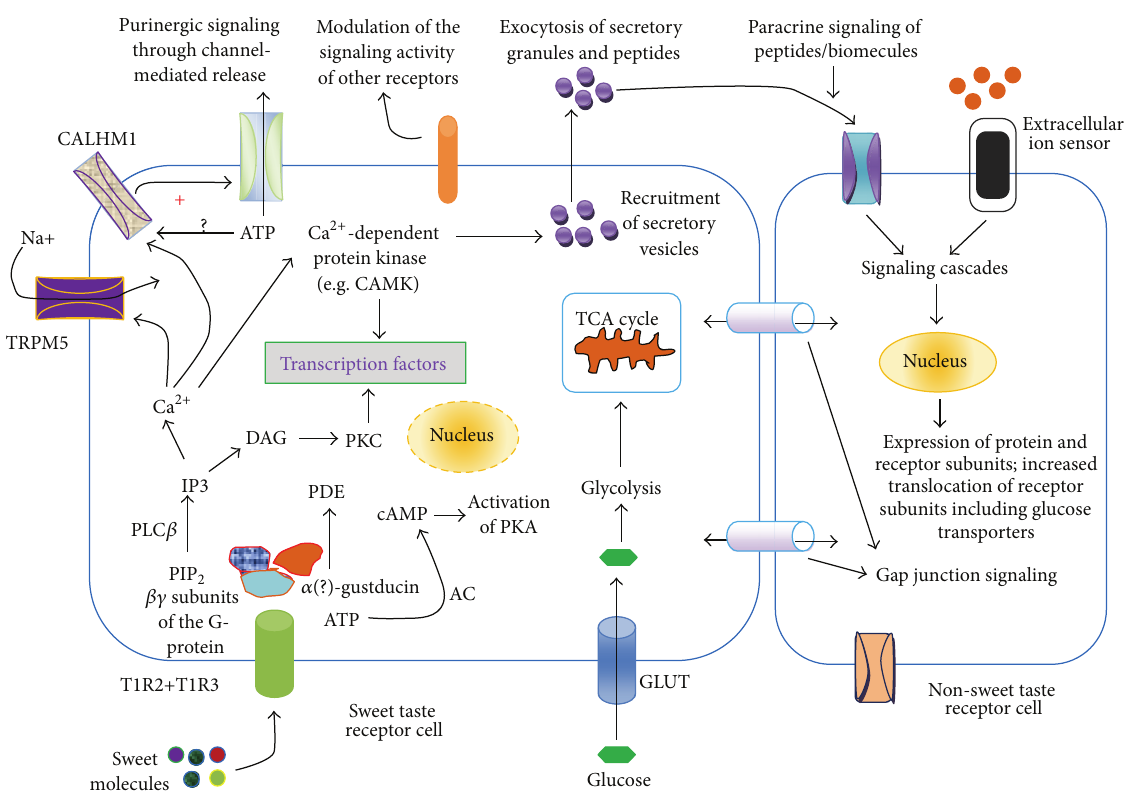
Figure 1: A general model of sweet taste signaling network. Sweet taste receptors possess multiple binding sites and mode of interaction for sweet molecules and they belong to class C of heterotrimeric guanine nucleotide-binding protein, G-protein [143–145]. Sweet molecules activate the G-protein by downstream signaling leading to the dissociation of the 𝛼 -subunit gustducin from the 𝛽𝛾 subunits [146, 147]. Dissociated 𝛽𝛾 subunits of the G-protein activate phospholipase C 𝛽 (PLC 𝛽 ), leading to the formation of 1,4,5-inositol trisphosphate (IP3). IP3 is responsible for the release of Ca 2+ from intracellular stores through its binding to IP3-receptor in these stores. Increase in intracellular Ca 2+ activates calcium dependent kinase, monovalent selective cation channel, TRPM5 (transient receptor potential cation channel, subfamily M, member 5) [15, 44, 146], and other receptors [44, 148]. To establish the role of TRPM5 or PLC 𝛽 (type 2), Zhang et al. [4] showed that knockout of the receptor or the enzyme abolishes the sensation of taste in cells. TRPM5 may also play a role in capacitance mediated calcium entry into taste cells [147]. Modulation of purinergic signaling by taste receptor also plays useful role in taste sensation. For the initiation of purinergic release, it was recently demonstrated by Taruno et al. [148] that the voltage-gated ion channel, calcium homeostasis modulator 1 (CALHM1),isindispensablefortaste-stimuli-evokedATPreleasefromsweet,bitter,andumamitastecells.Importantly,CALHM1isexpressed not only in sweet but also in bitter and umami taste sensing type2 cells. Taruno et al. [148] proposed that CALHM1 is a voltage-gated ATP- release channel. Dissociated 𝛼 subunit referred to as G 𝛼 -gustducin activates a phosphodiesterase (PDE) thereby decreasing intracellular cAMP levels [146, 149]. G 𝛼 -gustducin is also reported to activate adenylate cyclase (AC) to increase cAMP level [150]. According to earlier report, Clapp et al. [151] demonstrated that, compared to wild type mice, knockout of 𝛼 -gustducin in the taste buds of mice resulted in high basal (unstimulated) cAMP level. The results of these authors [151] indicated that 𝛼 -gustducin is necessary to maintain low level of cAMP level. Low level of cAMP is necessary to maintain the adequate signaling of Ca 2+ by disinhibition of cyclic nucleotide-inhibited channels to elevate intracellular Ca 2+ [38]. Changes in cAMP levels also affect other ion channels, including K + channels. The events resulting in activation/modulation of ion channels lead to membrane depolarization and formation of action potentials. Potential-dependent release of mediators (ATP, serotonin, etc.) and peptides and calcium dependent release of peptides/biomolecules are some of the results of sweet taste receptorsignaling[152].Ahallmarkofsweettastereceptorsignalingistheactivationoftranscriptionfactorsandgeneexpression,whichmight be dependent on calcium and activity dependent activation calcium dependent kinases, including the calmodulin-dependent protein kinase (CAMK). Activation of protein kinases may be achieved through other signaling pathways. It appears that sweet taste receptor signaling involves multiple activating substrates and different types and subtypes of both 𝛼 -gustducin and 𝛽𝛾 subunits of the G-protein. Although, different subtypes of sweet taste G-protein receptor subunits have been known for over a decade, their specific roles in sensing taste are not exactly clear [38, 149, 153]. For instance, Huangu et al. [149] reported the presence of 𝛽 1 and 𝛾 13. The sweet taste receptor is also known to , G 𝛼 , 𝐺𝛼 14 , 𝐺𝛼 15 , G 𝛼 , G 𝛼 , 𝛼 -transducin have been identified have 𝛽 3 subtype subunit. For 𝛼 -gustducin, G 𝛼 i- 2 i- 3 q s